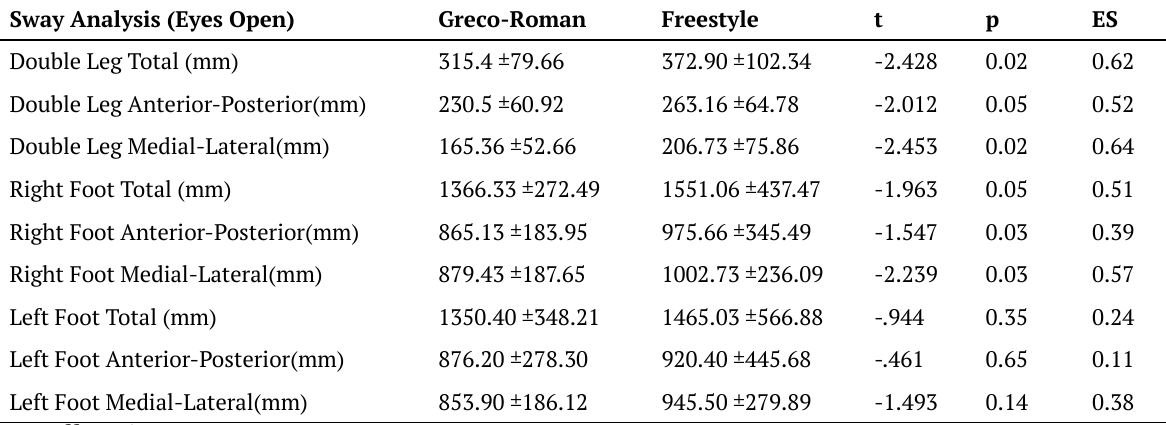
Table 3. Comparison of postural sway.